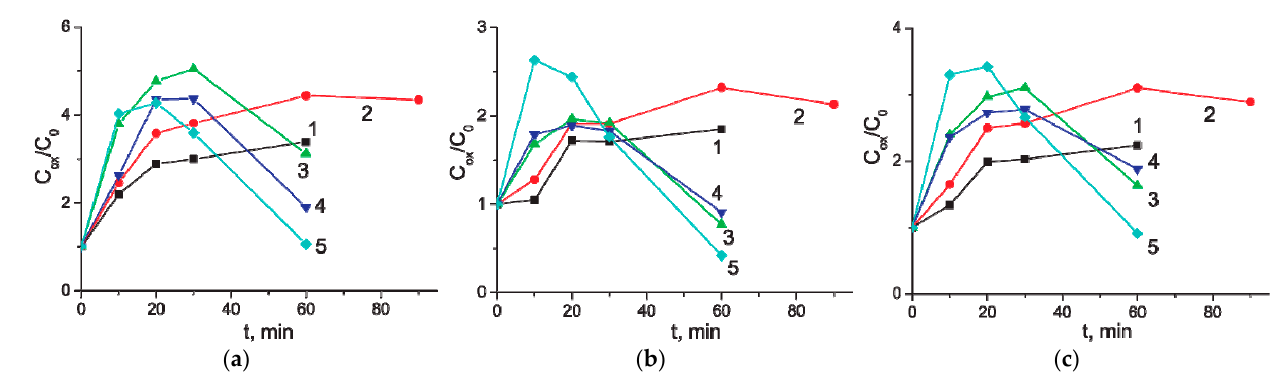
Figure 3. The ratio of the specific capacity of the modified and initial samples of MWCNT/Al ( C ox / C 0 ) versus the time of anodic oxidation. Electrolyte is 0.005 M aqueous Na 2 SO 4 solution. Potential of the electrochemical oxidation: 1–3 V; 2–4 V; 3–5 V; 4–6 V; 5–7 V. CVs range: ( a ) From − 800 to 10 mV; ( b ) From − 10 to 800 mV; ( c ) From − 800 to 800 mV.